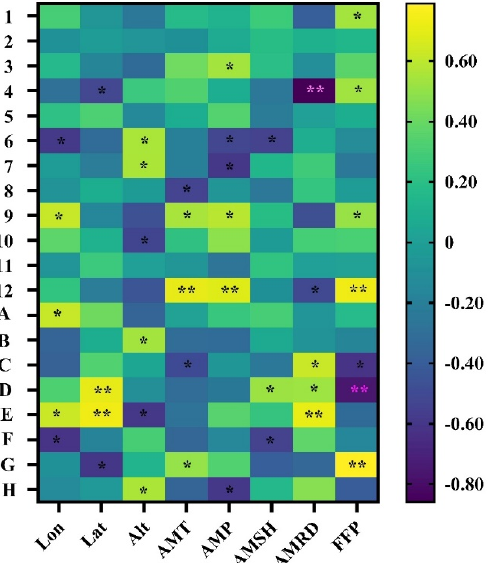
Figure 4. Correlative analysis between quality traits and environmental factors of H. acerba prove- nances. ** indicated very significant correlation ( p < 0.01), * indicated significant correlation ( p < 0.05). 1: Infructescence fat content; 2: Infructescence protein; 3: Infructescence tannin; 4: Infructescence total flavonoid; 5: Infructescence total saponin; 6: Infructescence soluble sugar; 7: Infructes ‐